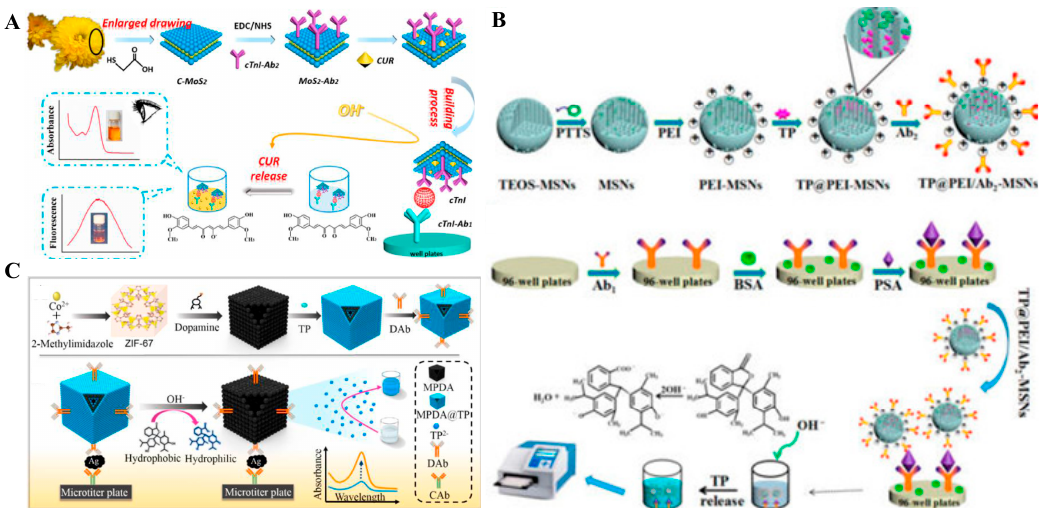
Figure 16. ( A ) Diagram of the drug delivery system inspired enzyme-linked immunosorbent assay (DDS-ELISA) for the detection of cTnI in 96-microwell plates. Reproduced with permission from [175]. Copyright American Chemical Society, 2018. ( B ) Synthesis and derivatization of TP@PEI/Ab 2 -MSNs and steps of the enzyme-free immunosorbent assay of PSA using TP@PEI/Ab 2 -MSNs for amplified colorimetric detection in a 96-well plate. Reproduced with permission from [176]. Copyright American